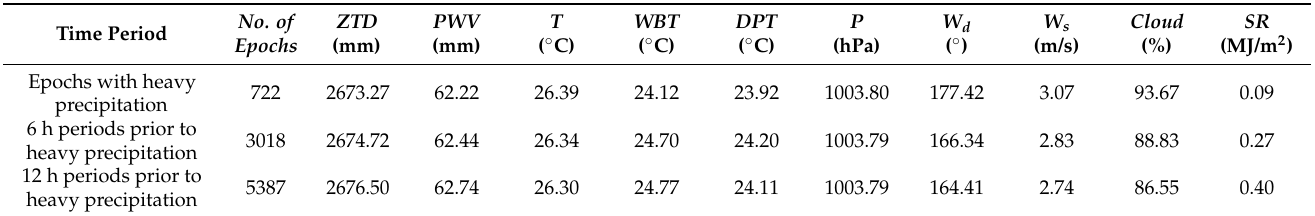
Table 7. Comparison of mean values obtained at the 6 h and 12 h periods prior to heavy precipitation over the period